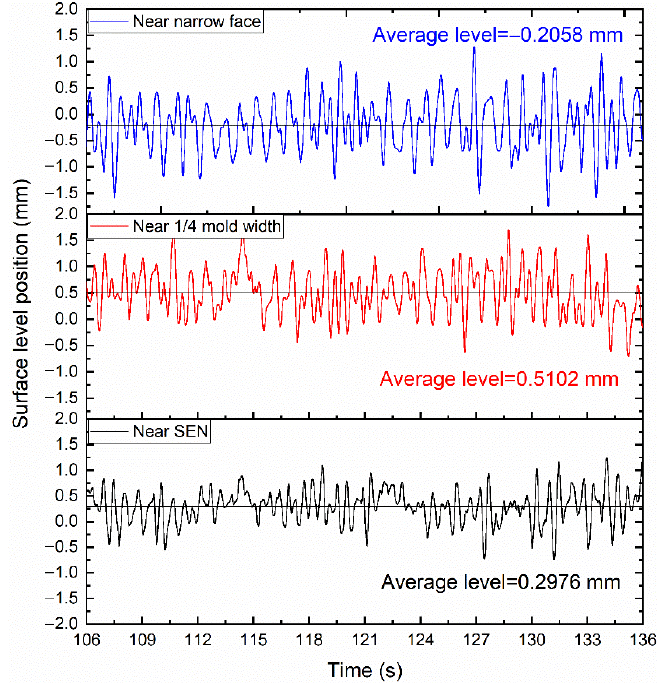
Figure 5. The variation in surface level over time at different locations.